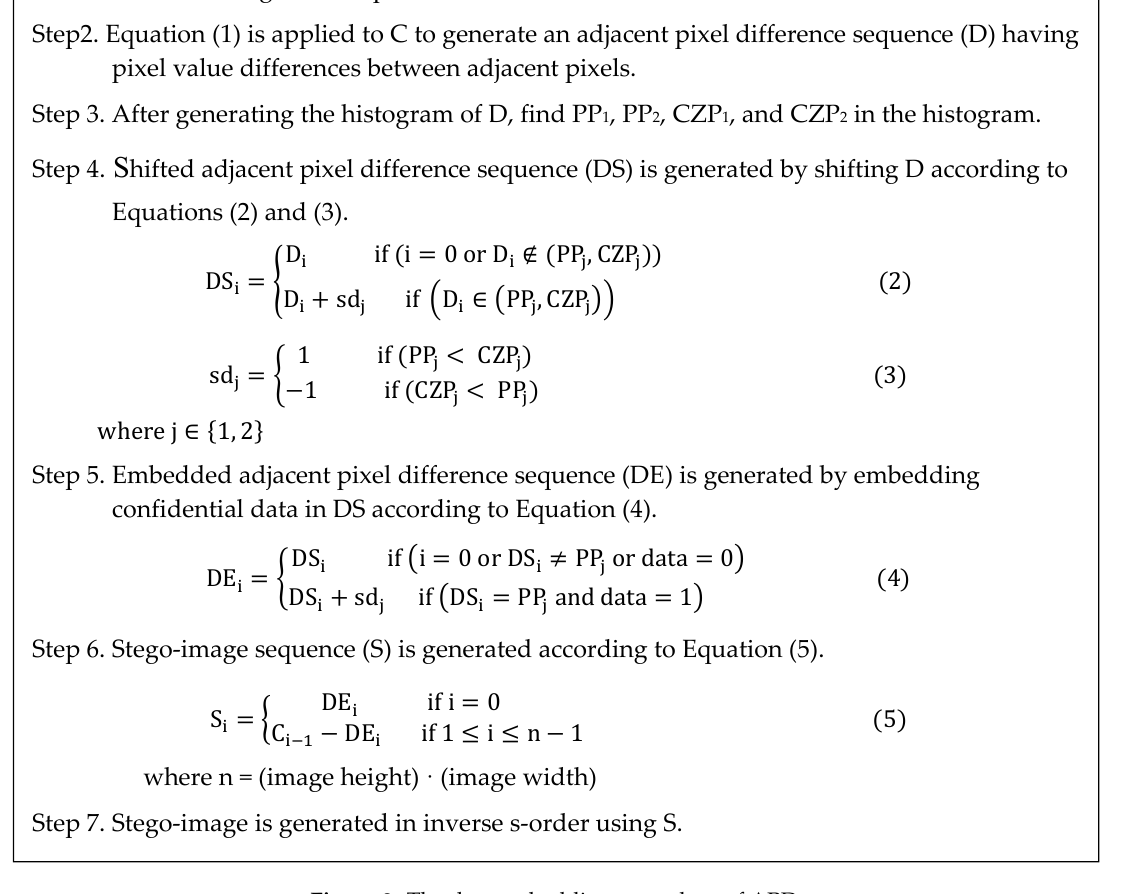
Figure 2. The data embedding procedure of APD.